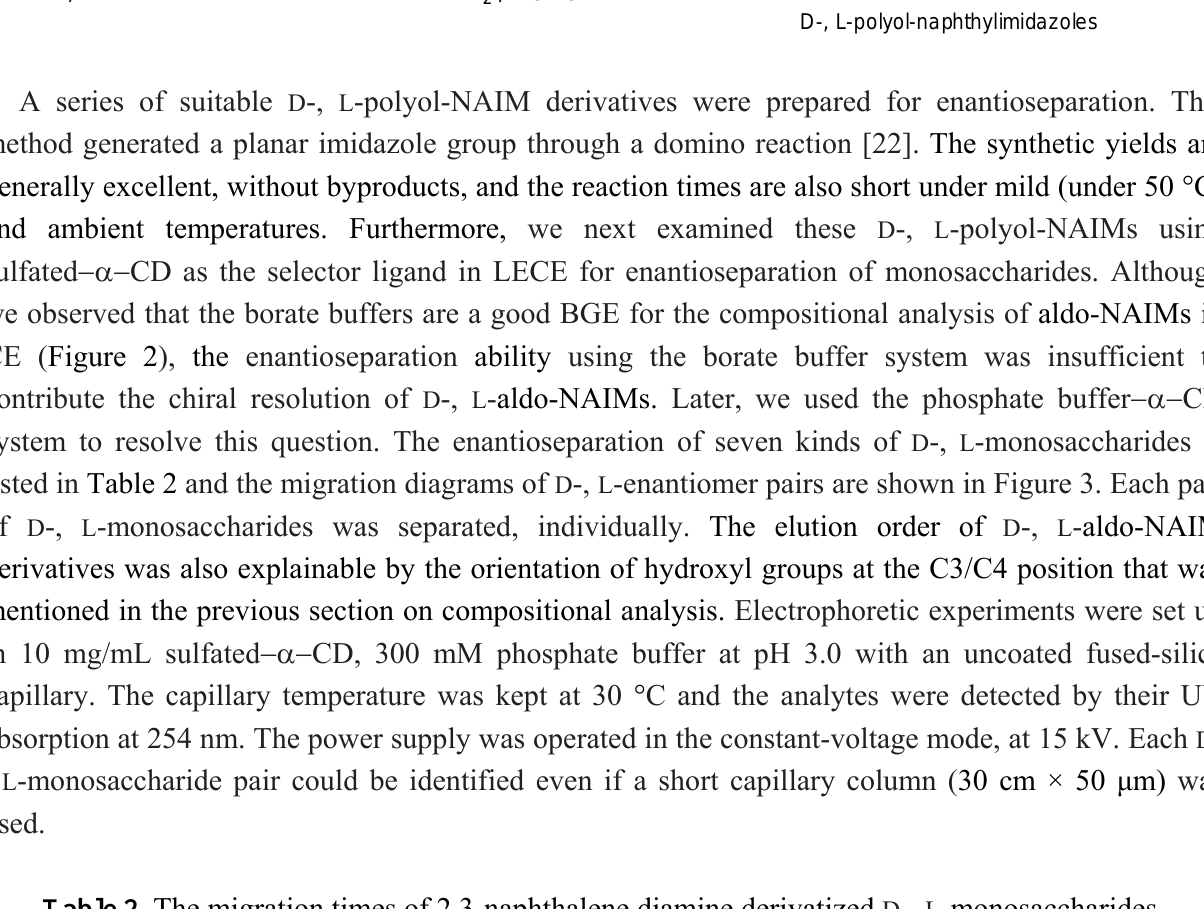
Table 2. The migration times of 2,3-naphthalene diamine derivatized D -, L -monosaccharides. D-enantiomer Migration time (min) L-enantiomer Migration time (min) D-Manno-NAIM